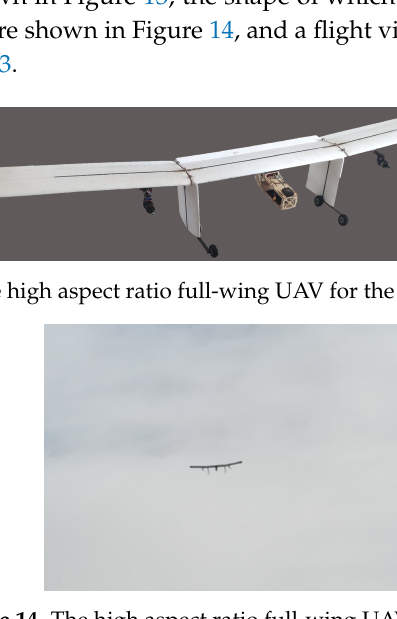
Figure 14. The high aspect ratio full-wing UAV in flight.